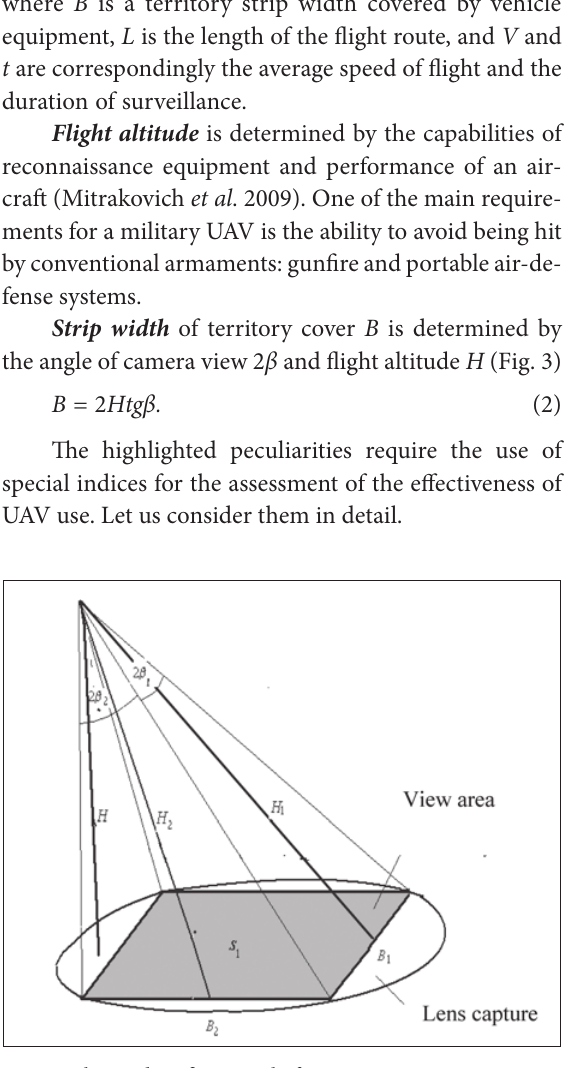
Fig. 1. Scanning of fixed area